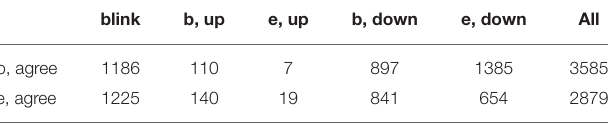
TABLE 5 | Emblem/agree—frequency of items from the gaze class.